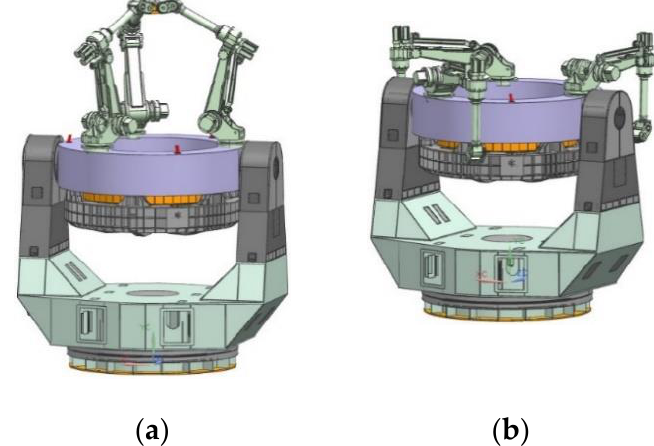
Figure 1. Robotics-based telescope in ( a ) observation state and ( b ) transport state.